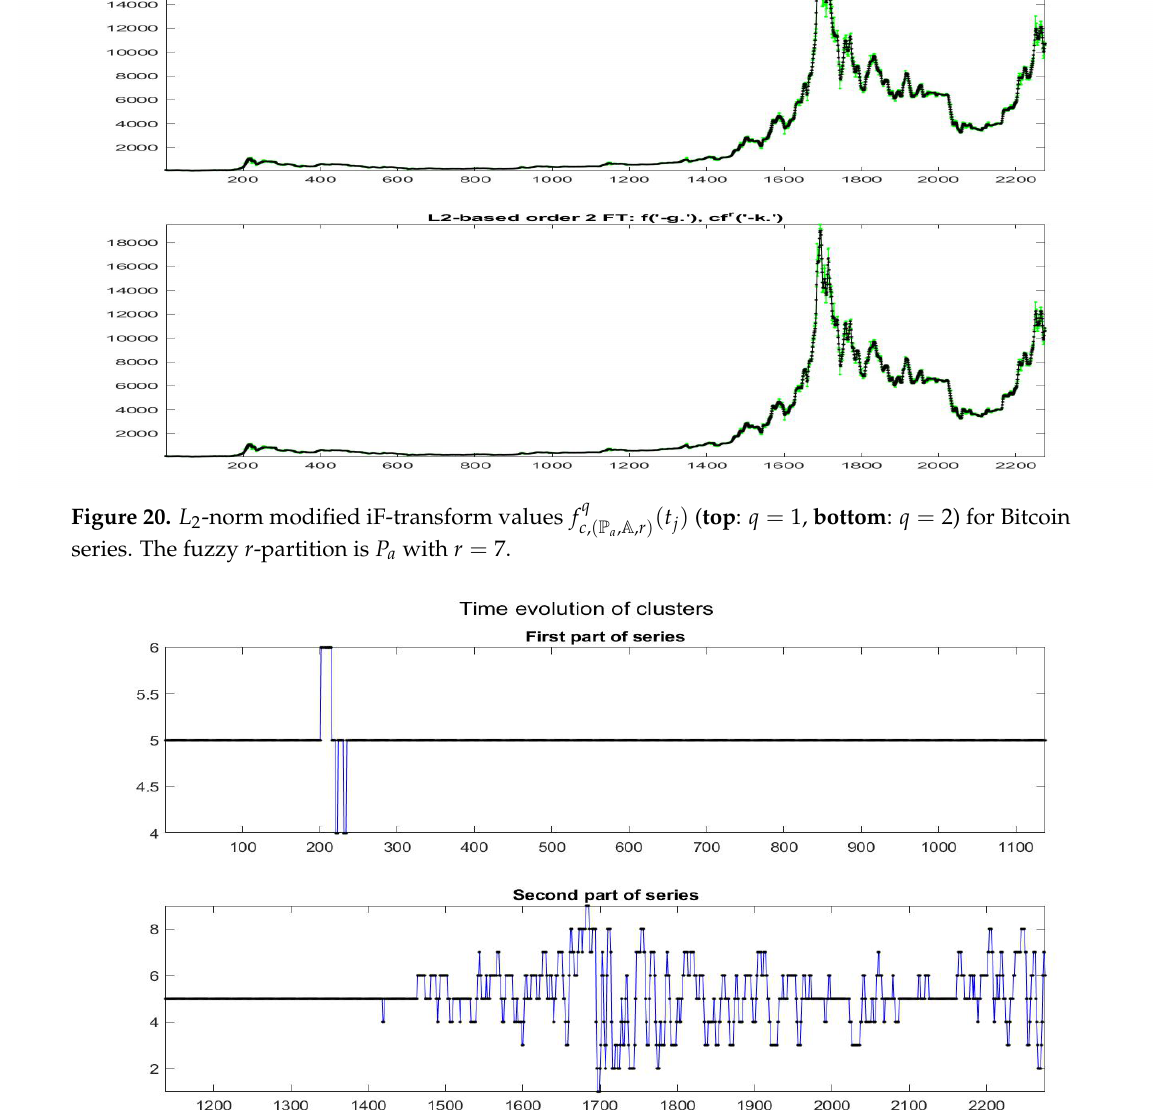
Figure 21. Time evolution of clusters obtained with the L 2 -norm F-transform smoothing of order 1 for Bitcoin series. The fuzzy r -partition is P a with r =